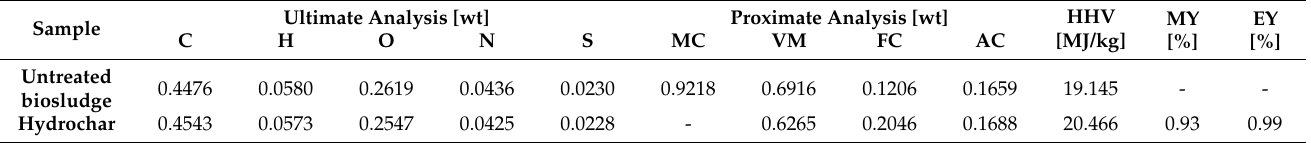
Table 3. Characterization analysis of feedstock and hydrochar (3 h at 160 ◦ C) samples. All data are dry-basis, except for MC, which is mass fraction of wet sludge. The HHV was determined experimentally as described in Section